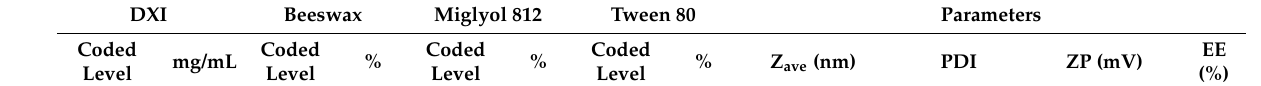
Table 3. Values of the experimental factors according to the matrix designed by 2 4 + star central composite rotatable factorial design parameters and measured